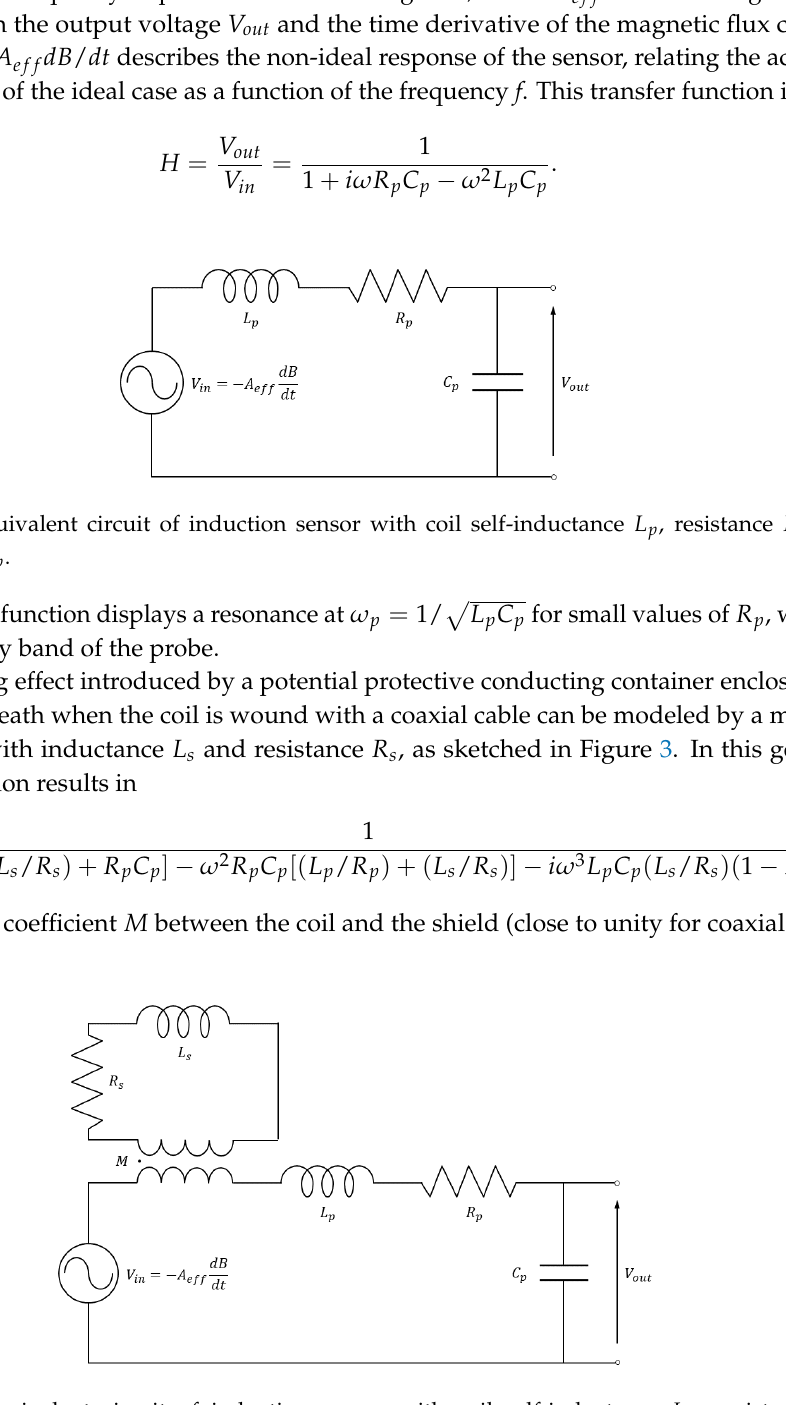
Figure 3. Equivalent circuit of induction sensor with coil self-inductance L p , resistance R p , and capacitance C p , shield self-inductance L s , resistance R s and coupling coefficient M